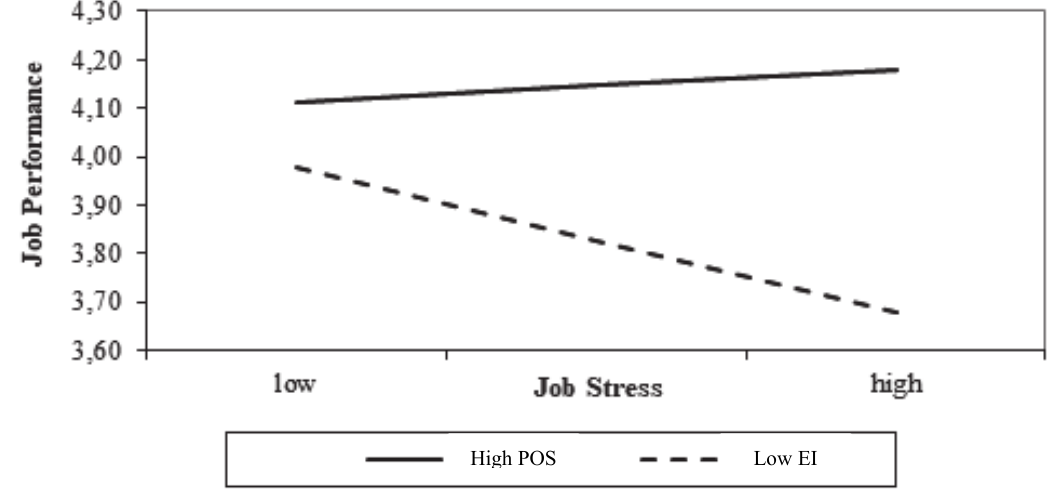
Fig. 3. Moderating effect of perceived organizational support (POS) on job stress - job performance